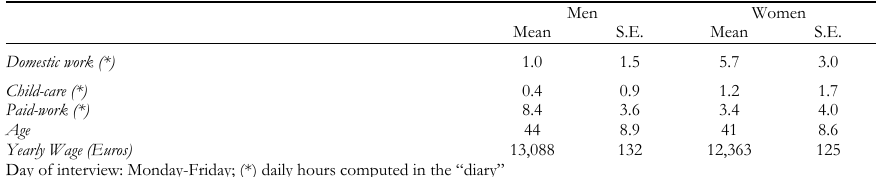
Partner characteristics on selected variables